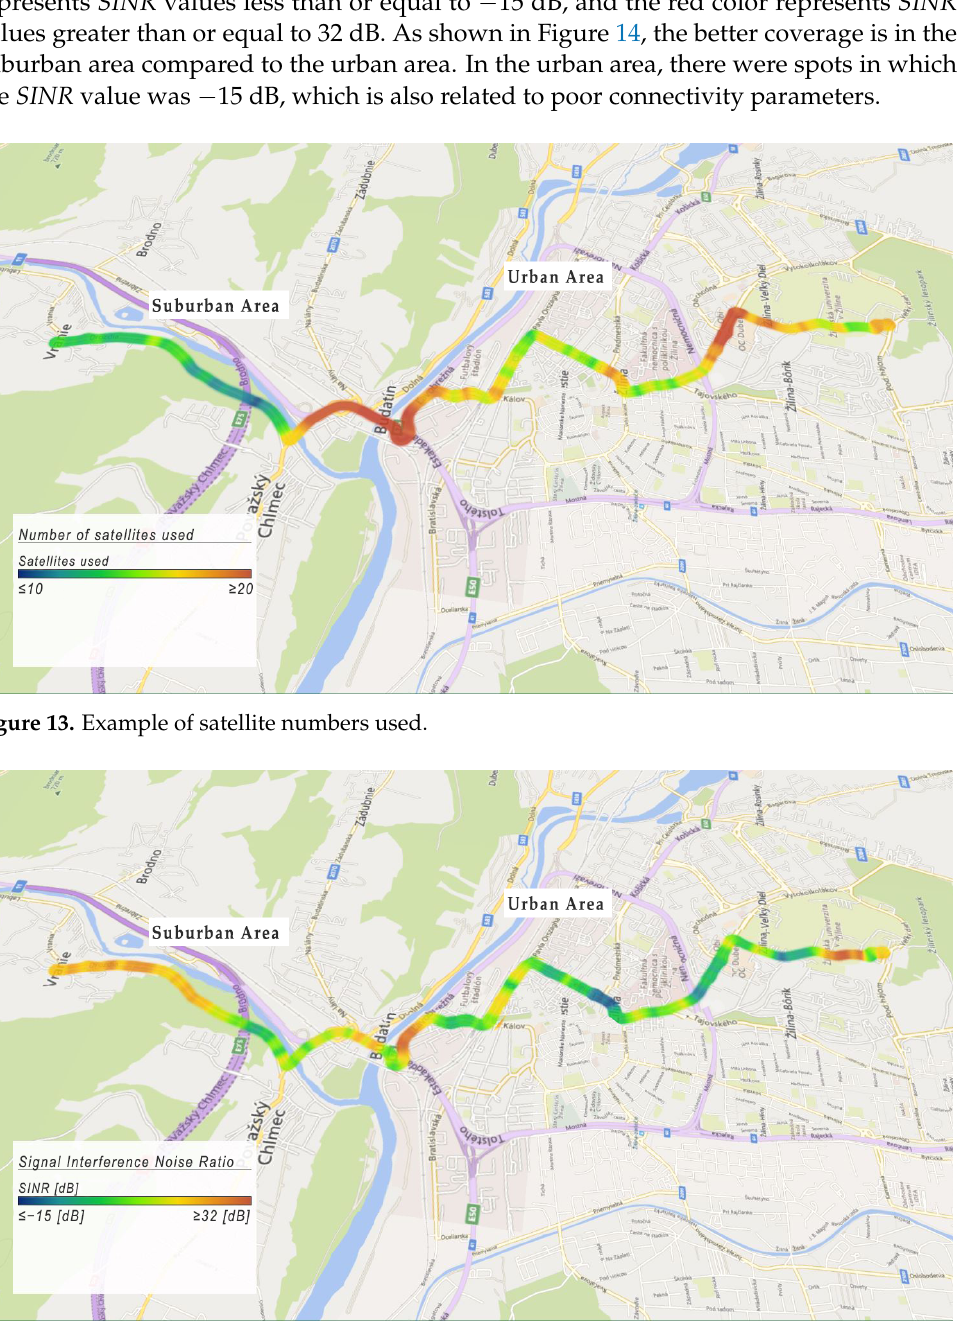
Figure 14. Example of Signal Interference Noise